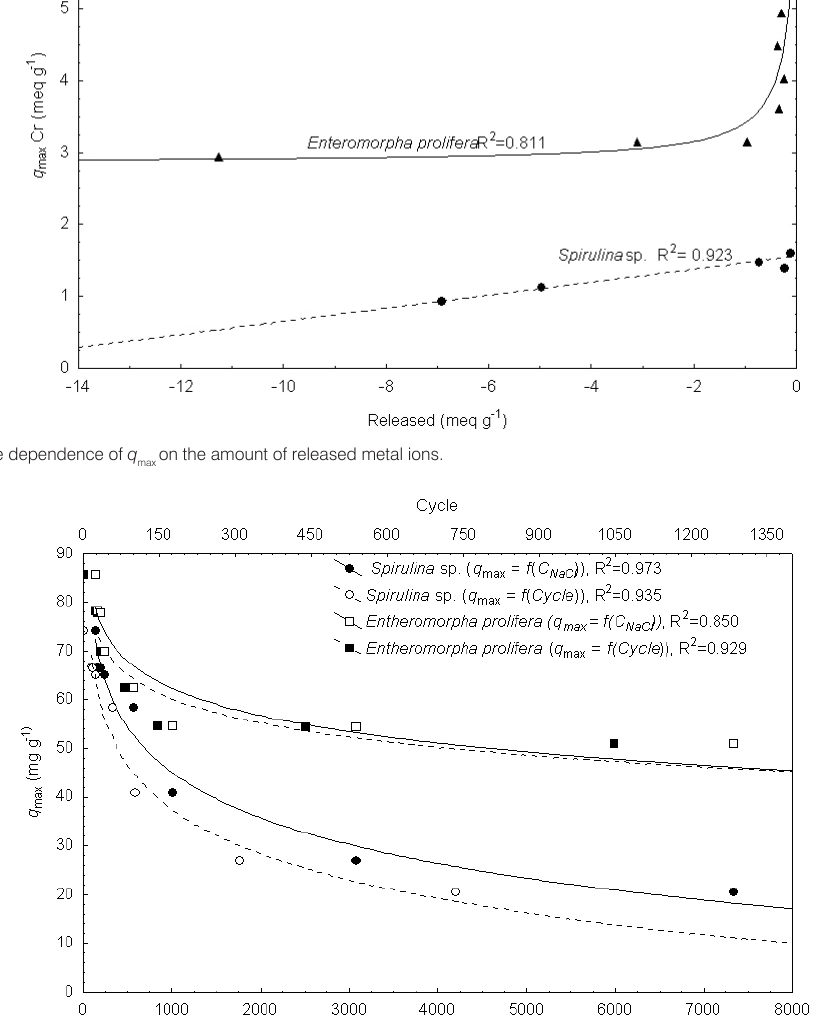
Figure 4. Decrease in q capacity of Enteromorpha prolifera and Spirulina sp. towards Cr(III) ions with increase in concentration of NaCl and max the number of recycle